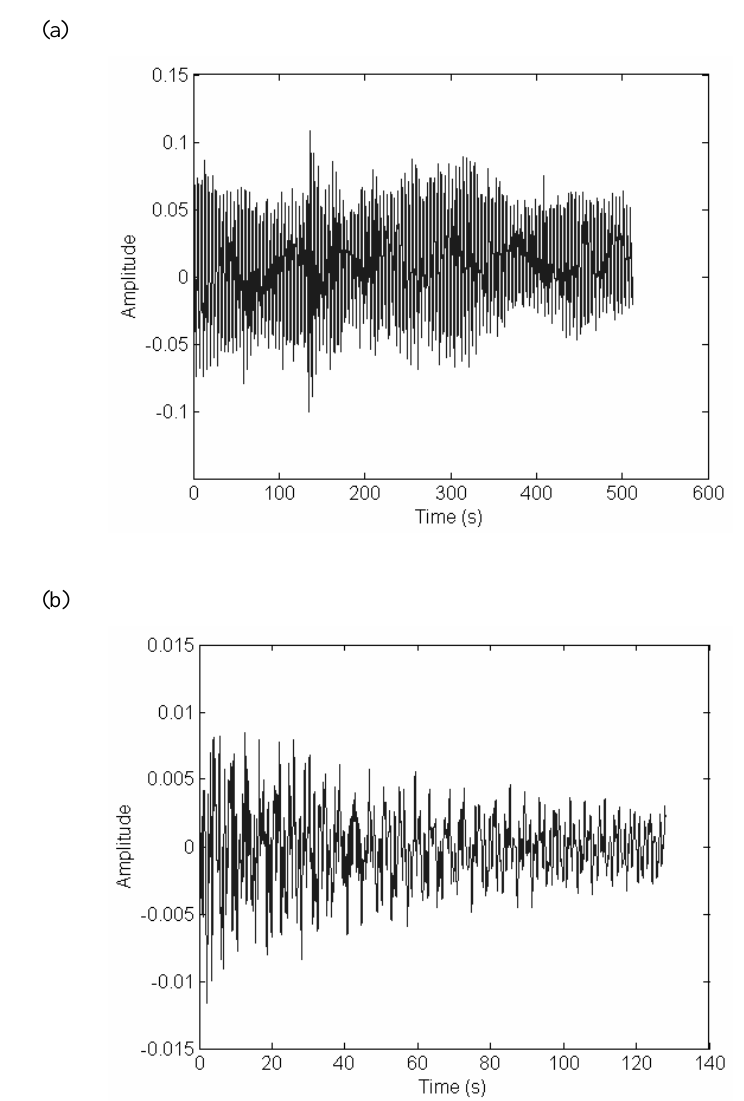
Fig. 2. (a) Ambient response; (b) Free response from the random decrement